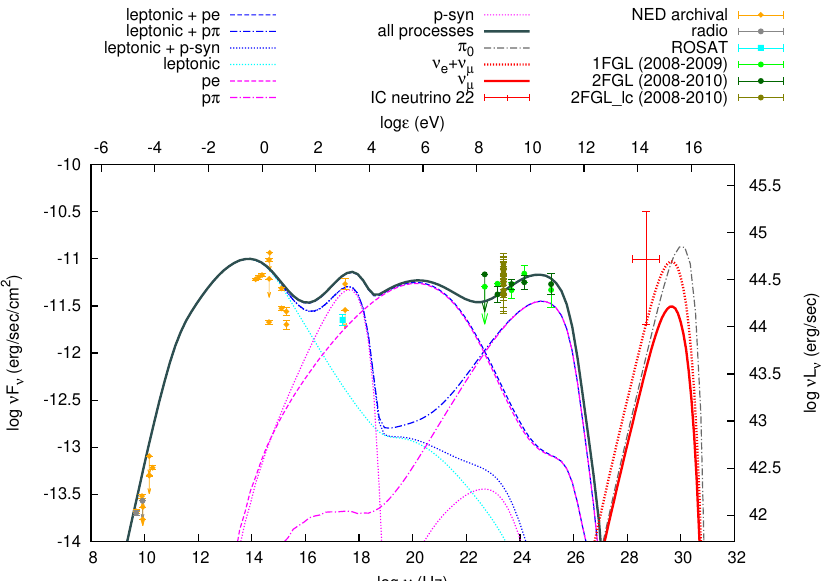
Figure 3. Example of a complex lepto-hadronic model, applied to the SED of the BL Lac object 1H1914-194, including synchrotron and SSC emission from primary leptons, proton-synchrotron emission, and radiation from secondary leptons generated in Bethe-Heitler pair production (“pe”) and photo-pion production (“p π ”). In addition, the neutrino spectrum emerging from hadronic interactions is shown at the highest energies. (taken from [35])